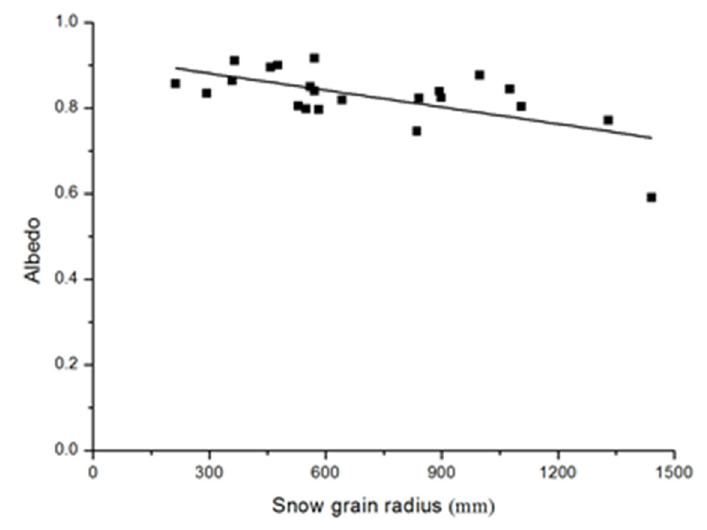
Figure 9. Relationship between snow particle size and albedo of the QT No. 1 Glacier in 2015.